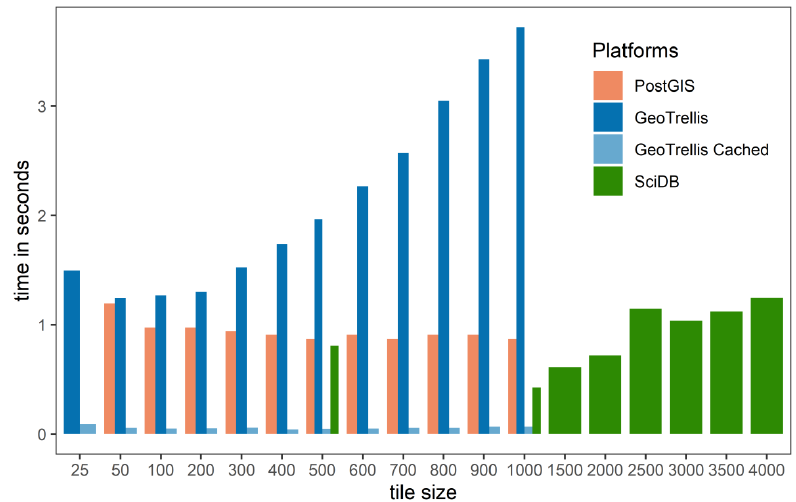
Figure 2. Performance of reclassification on dataset GLC on all platforms. Table 6. Reclassification best time and speed-up for all raster datasets.